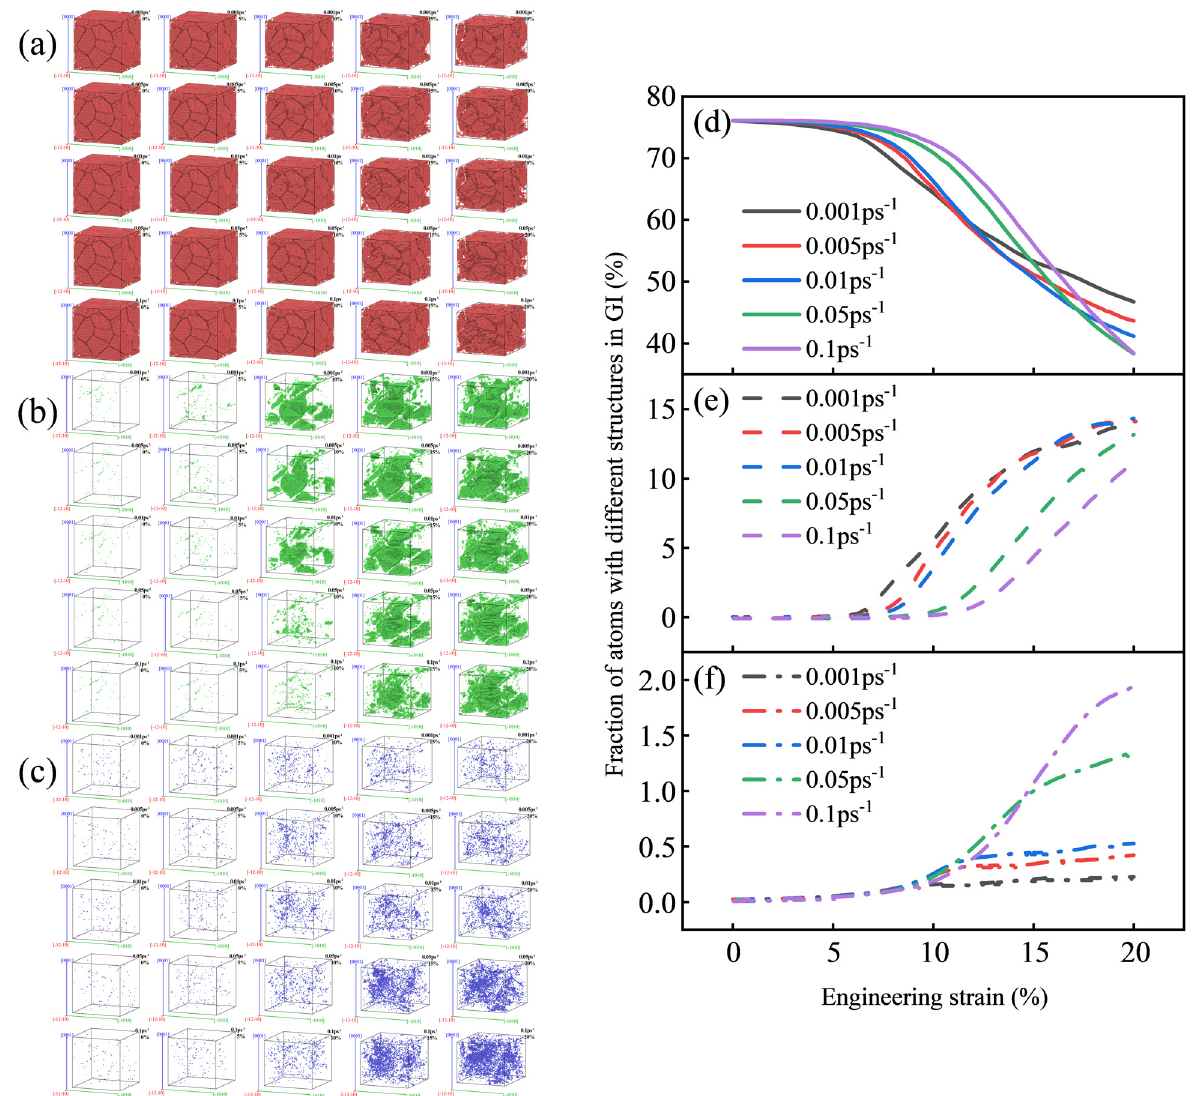
Figure 21: Structural evolution: ( a ) CNA diagram of HCP structure, ( b ) CNA diagram of FCC structure, ( c ) CNA diagram of BCC structure, ( d ) atomic curve of HCP structure, ( e ) atomic curve of FCC structure, and ( f ) atomic curve of BCC